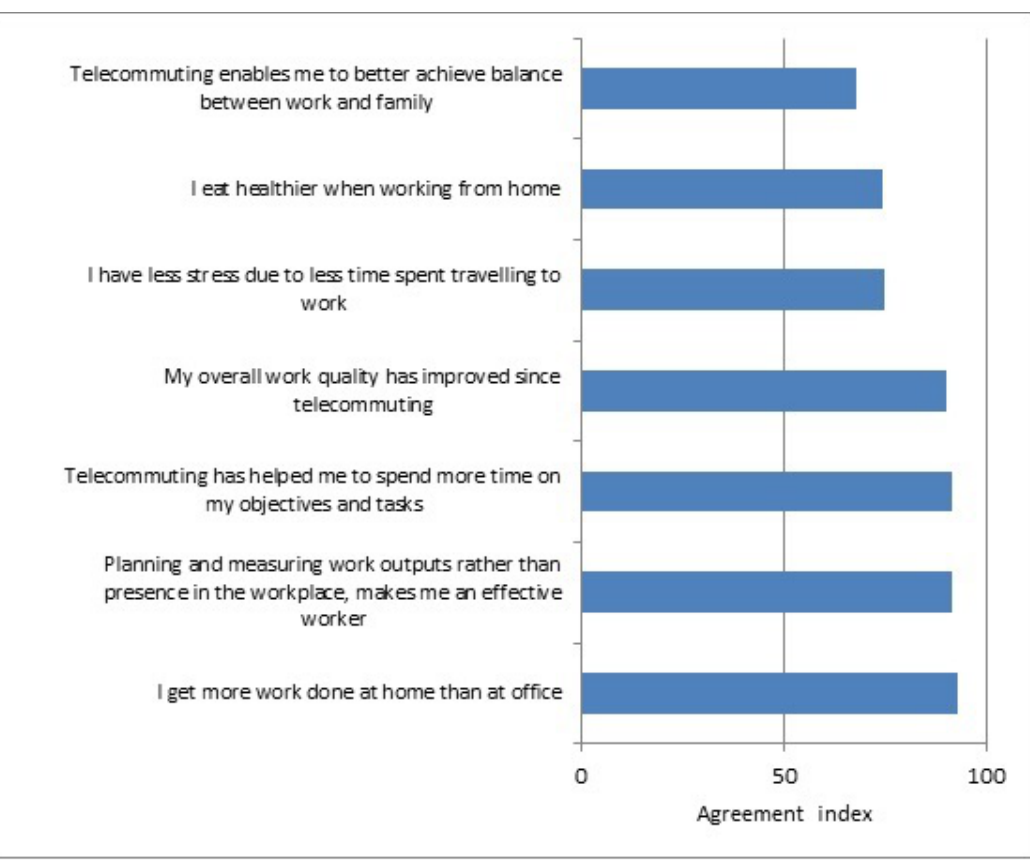
Figure 3. Work effect of telecommuting on academic